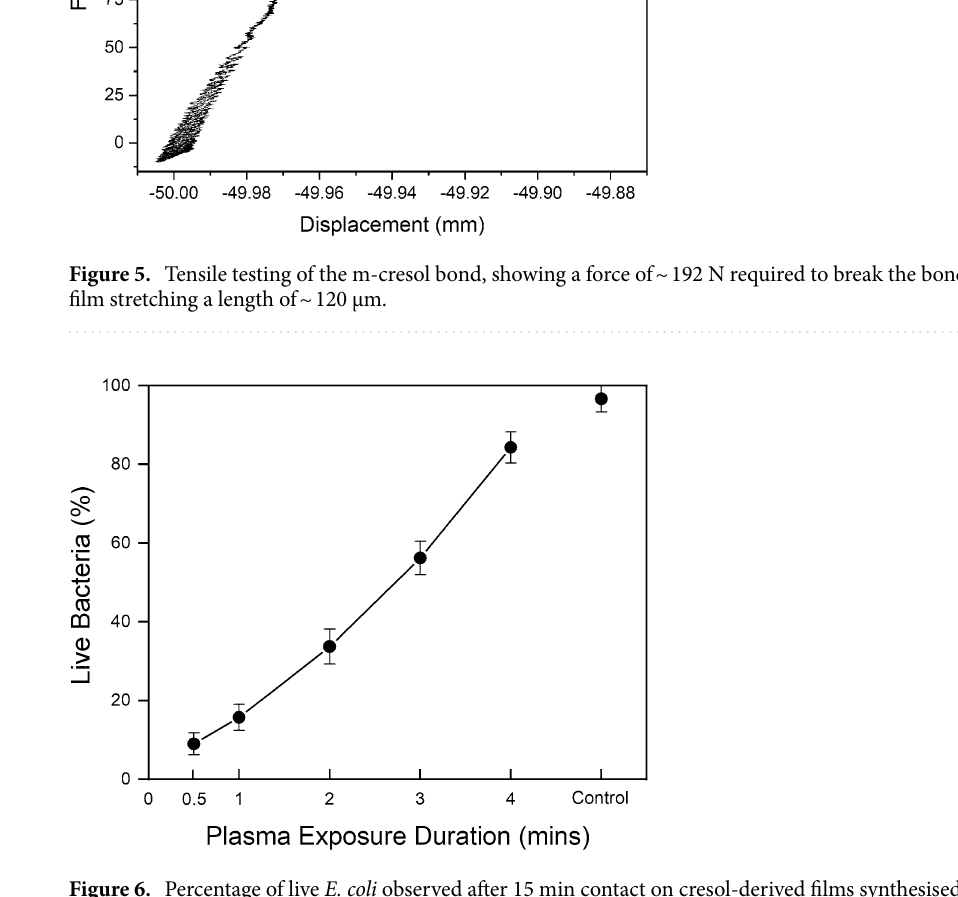
Figure 6. Percentage of live E. coli observed after 15 min contact on cresol-derived films synthesised using different plasma exposures, compared to the uncoated silicon wafer control. A line between each data point guides the eye for the antimicrobial activity of the films, and error bars show the standard deviation of live bacteria, calculated from triplicate tests of the dot point mean values. A similar level of uncertainty is seen in the coated samples as in the control, and we attribute this to the uncertainty produced from the expected slightly variable natural death rate of the triplicate bacteria